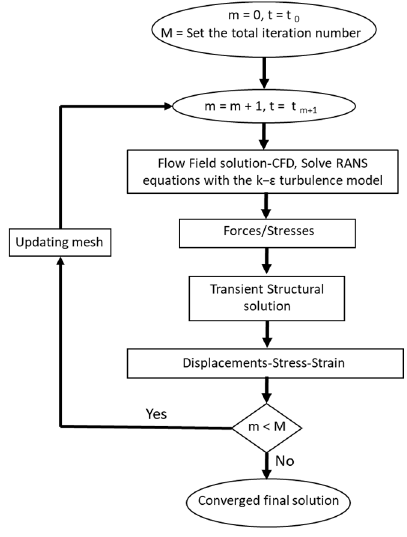
Figure 5. Numerical steps of system coupling.